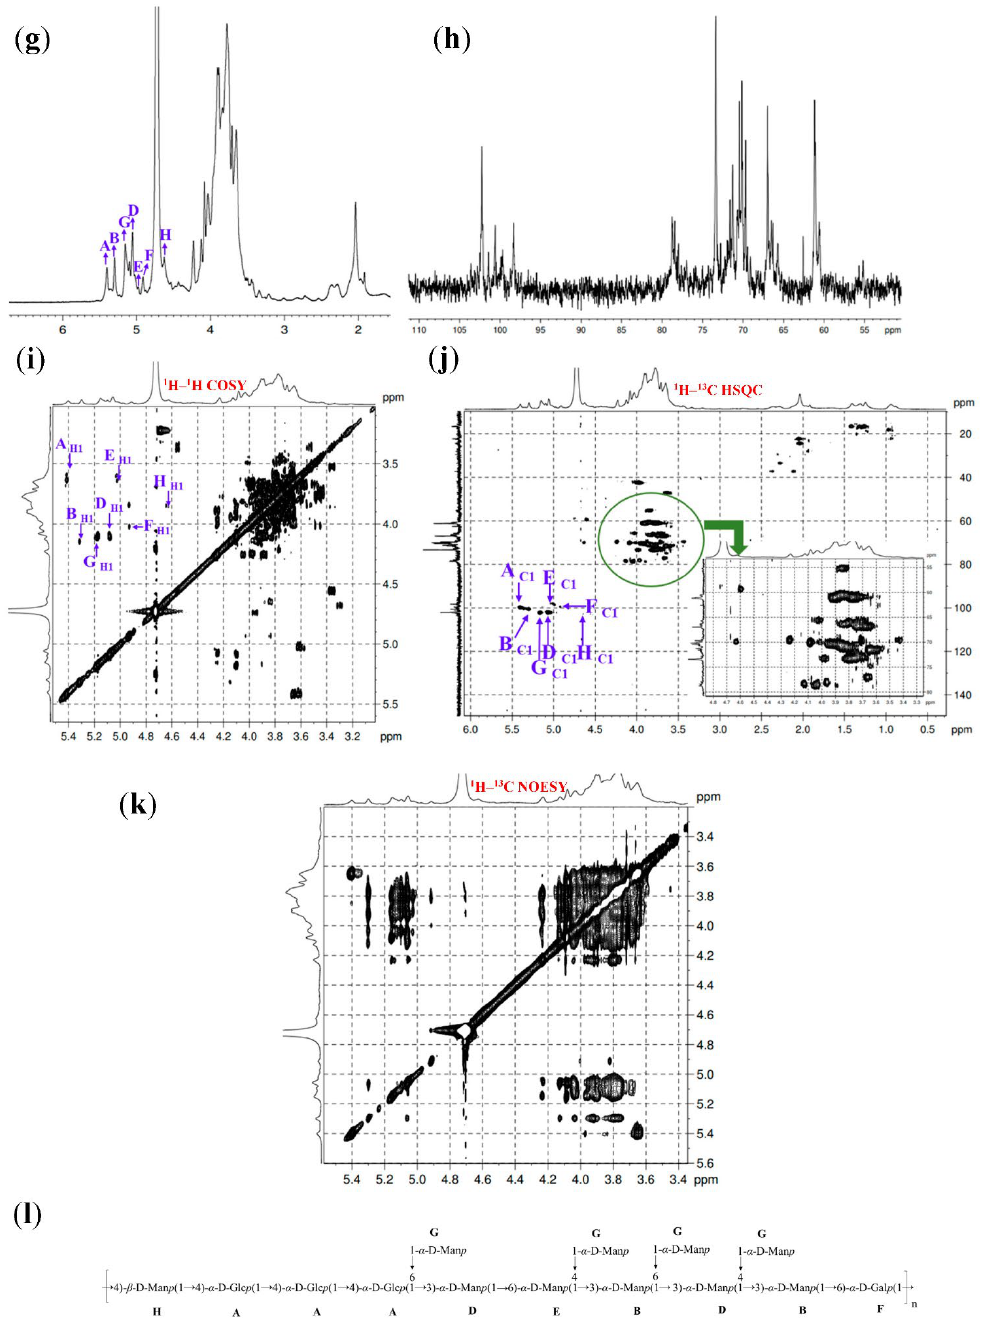
Figure 3. The NMR spectra and proposed structures of GL1-E1 and GL1-E2. The 1 H NMR spectrum of GL1-E1 ( a ), 13 C NMR spectrum of GL1-E1 ( b ), 1 H 1 –H COSY spectrum of GL1-E1 ( c ), 1 H– 13 C HSQC spectrum of GL1-E1 ( d ), NOESY spectrum of GL1-E1 ( e ), and proposed structure of GL1-E1 ( f ); 1 H NMR spectrum of GL1-E2 ( g ), 13 C NMR spectrum of GL1-E2 ( h ), 1 H– 1 H COSY spectrum of GL1-E2 ( i ), 1 H– 13 C HSQC spectrum of GL1-E2 ( j ), NOESY spectrum of GL1-E2 ( k ), and proposed structure of GL1-E2 ( l